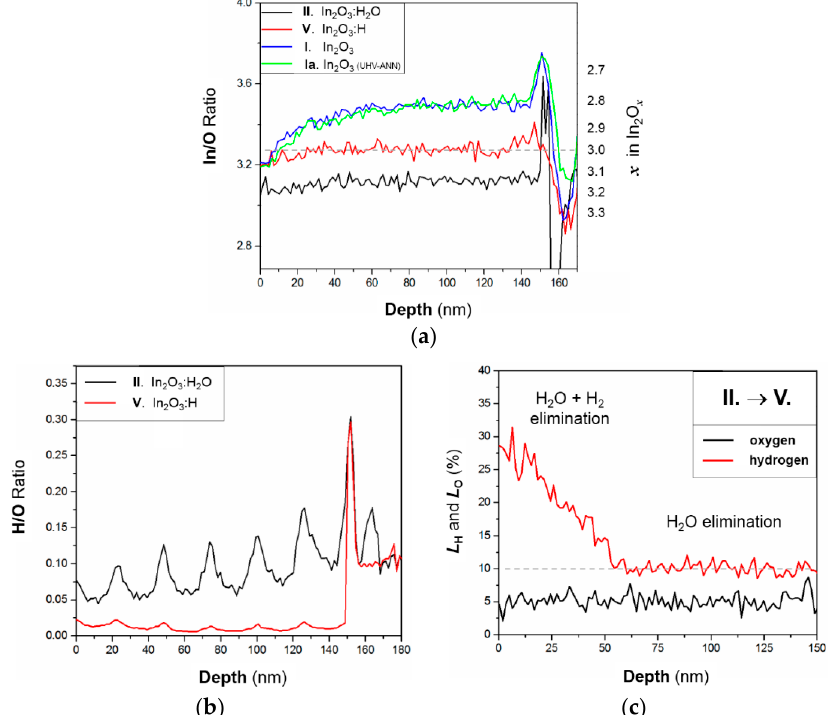
Figure 5. SIMS depth profiles obtained on various ~150 nm thick DC sputtered In 2 O 3 films. Indium to oxygen concentration ratios ( a ) were obtained for the film states I, II and V, which correspond to the Table 1. State Ia represents the UHV-annealed In 2 O 3 film. Hydrogen to oxygen concentration ratio ( b ) and the percentage losses of hydrogen and oxygen ( c ) are compared for the as-deposited and annealed states of the film, intentionally containing water.